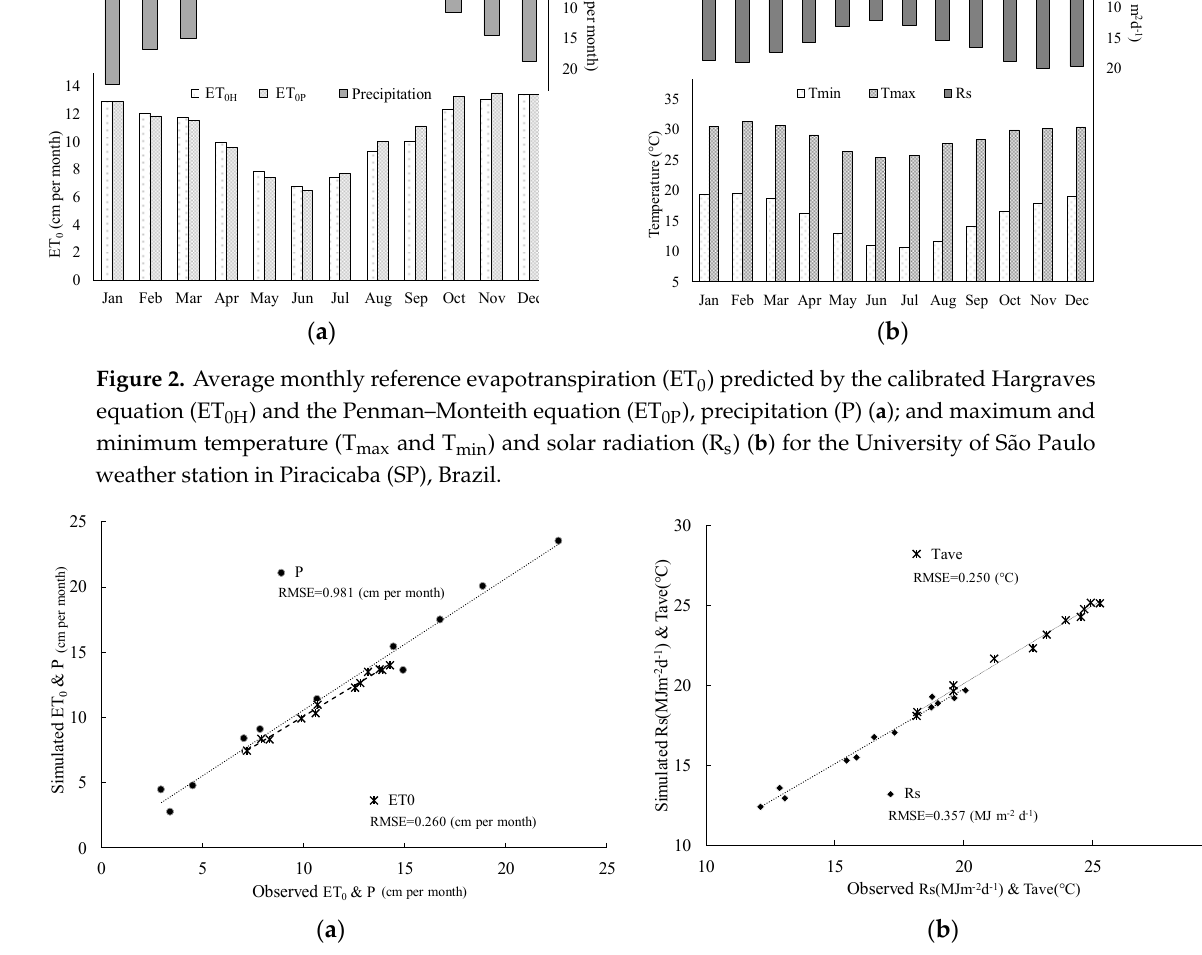
Figure 3. Observed meteorological data versus simulated ones by LARS-WG: ( a ) Rainfall (P) and evapotranspiration (ET 0 ); ( b ): radiation (R a ) and average temperature (T ave ).